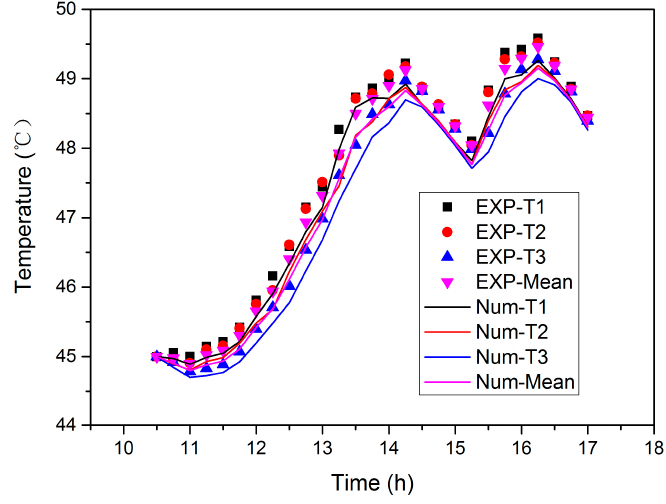
Figure 7. Comparisons of numerical and experimental results.